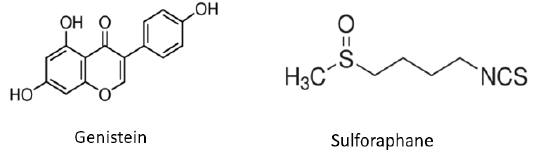
Figure 1. Structure of genistein (GEN) and sulforaphane (SFN). The chemical structures of GEN and SFN are displayed.